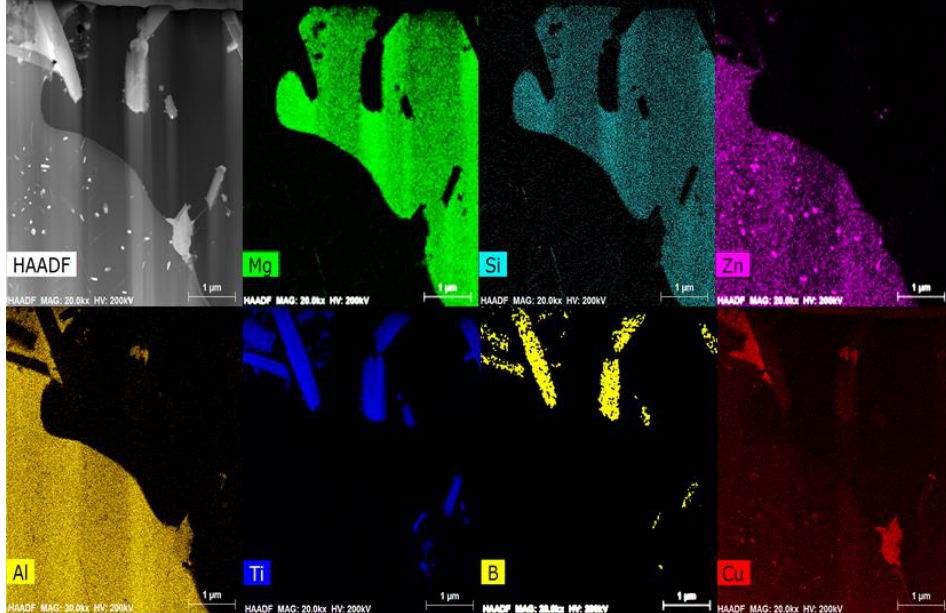
Figure 5. TEM and EDS analysis data of modified eutectic Al + Mg 2 Si phases in the Al–8Zn–6Si– 4Mg–2Cu–1Ti alloy.